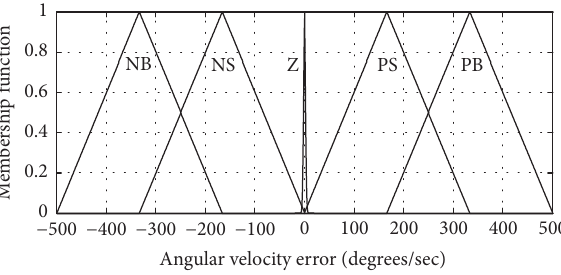
Figure 4: Fuzzy sets for angular velocity error.